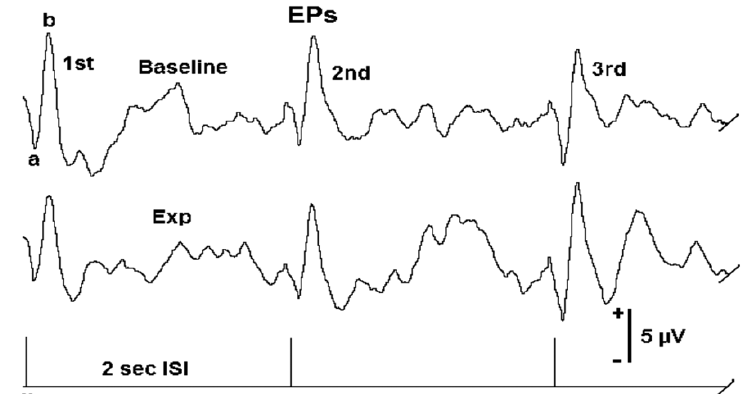
Figure 1 - Example of the first three P2 waves of the evoked potentials (EPs) recorded before (Baseline) and after (Exp) a subject received the drink in the alcohol group. The horizontal axis represents the 2-sec ISI train of auditory stimuli with the auditory stimuli represented by the vertical lines. The upper traces are the averaged 32-EEG records showing that each stimulus produces a corresponding EP. The onset (N1) and peak (P2) of the EPs are identified by a and b, respectively. The latency to peak was measured in the segment x-b. The slope of a straight line joining the segment a-b identifies the rate of rise. Peak-to-peak amplitude is the magnitude of the wave from a-b